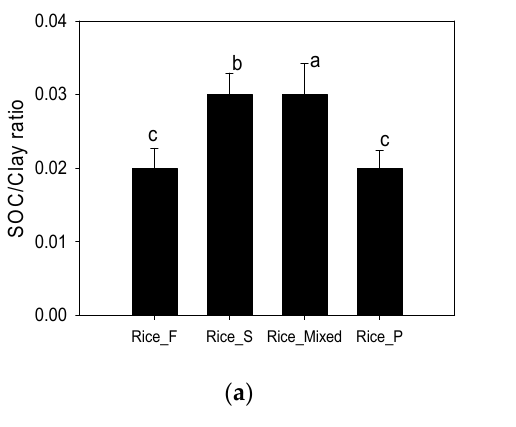
Figure 6. SOC/clay ratio ( a ) and DOC stored ( b ) as a result of the RRCS. Note: The bars with the standard error of the mean and labeled with different lowercase letters indicate a difference between rice rotation patterns ( p < 0.05). In the rice cultivation system, different crops are used each year. Rice_ F = rice followed by a fallow period, i.e., no plantation; Rice_S = rice followed by shallots; Rice_Mixed = rice followed by tobacco, maize, and vegetables; and Rice_P = rice followed by potato.